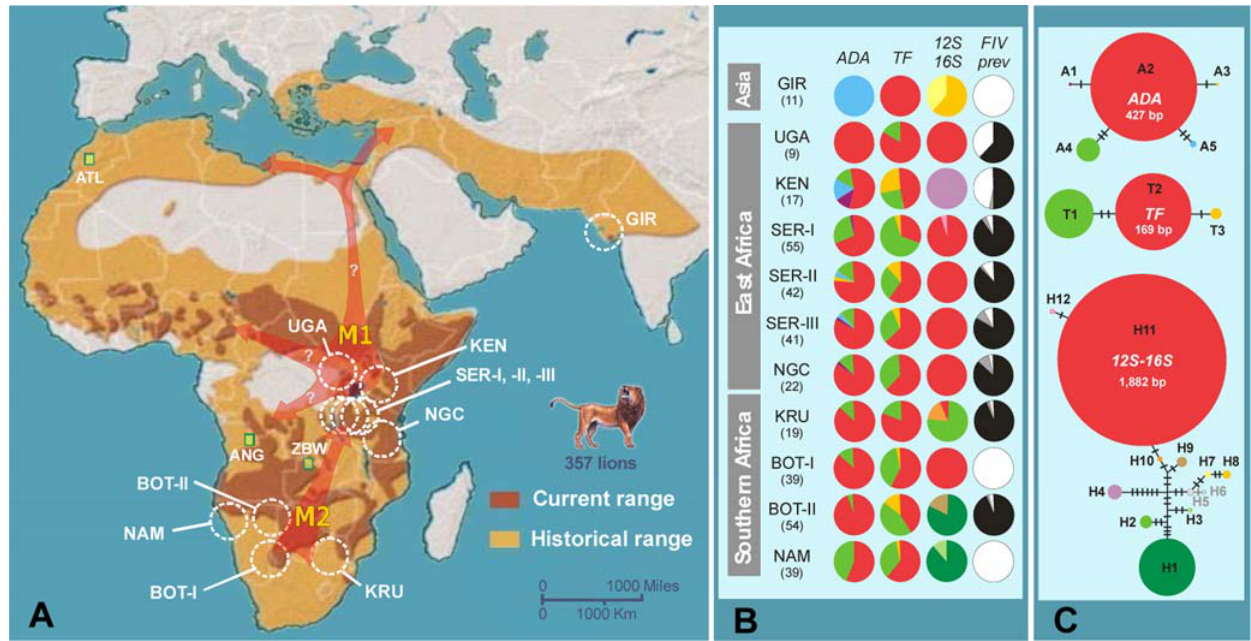
Figure 1. Geographic location of the lion samples and the variability of host and viral genetic markers among lion populations. (A) Historical and current geographic distribution of lion, Panthera leo . A three-letter code pointing to a white dotted circle represents the geographic location of the 11 lion populations determined by Bayesian analyses [22] and factorial correspondence analyses [23] of the genetic distinctiveness of 357 lion samples (see text): GIR, Gir Forest, India; UGA, Uganda (Queen Elizabeth National Park); KEN, Kenya (Laikipia), SER, Serengeti National Park, Tanzania; NGC, Ngorongoro Crater, Tanzania; KRU, Kruger National Park, South Africa; BOT-I, southern Botswana and Kalahari, South Africa; BOT-II, northern Botswana; and NAM, Namibia. Green squares represent captive individual samples to explore the relationship of lions from more isolated/ endangered/depleted areas: ATL, Morocco Atlas lions ( n =4); ANG, Angola ( n =2); and ZBW, Zimbabwe ( n =1). Deduced historical expansions (M1 and M2) are represented by red arrows (see text). (B) Haplotype frequencies observed in the 11 lion populations for nDNA ( ADA and TF ), and mtDNA ( 12S – 16S ) genes, paralleled with the FIV Ple serum-prevalence frequencies (black – sero-positive; gray – indeterminate; white – sero-negative). Population sample sizes are indicated within parenthesis. (C) Statistical parsimony networks of lion ADA , TF , and 12S – 16S haplotypes. Circle size is proportional to the haplotype frequency and crossbars represent the number of step mutations connecting haplotypes. The mtDNA haplotypes H5 and H6 are shaded gray as they were detected only in the individual samples from ANG, ATL, and ZBW, which do not group in unique population clusters (see text).